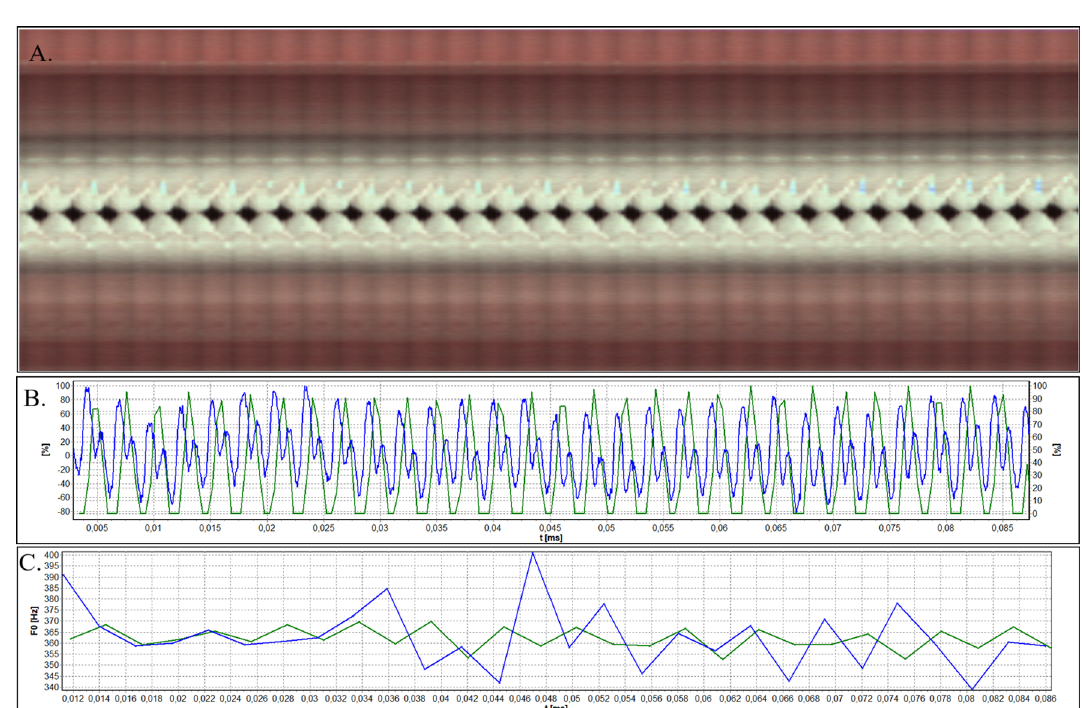
Figure 3. Analysis of HSV data acquired by means of rigid endoscope for Subject 1. ( A ). Videokymogram; ( B ) Comparison of the glottal width waveform obtained from a videokymogram (green line) and the audio signal oscillogram (blue line); ( C ) Comparison of F0 obtained from a videokymogram (green line) and acoustic voice analysis (blue